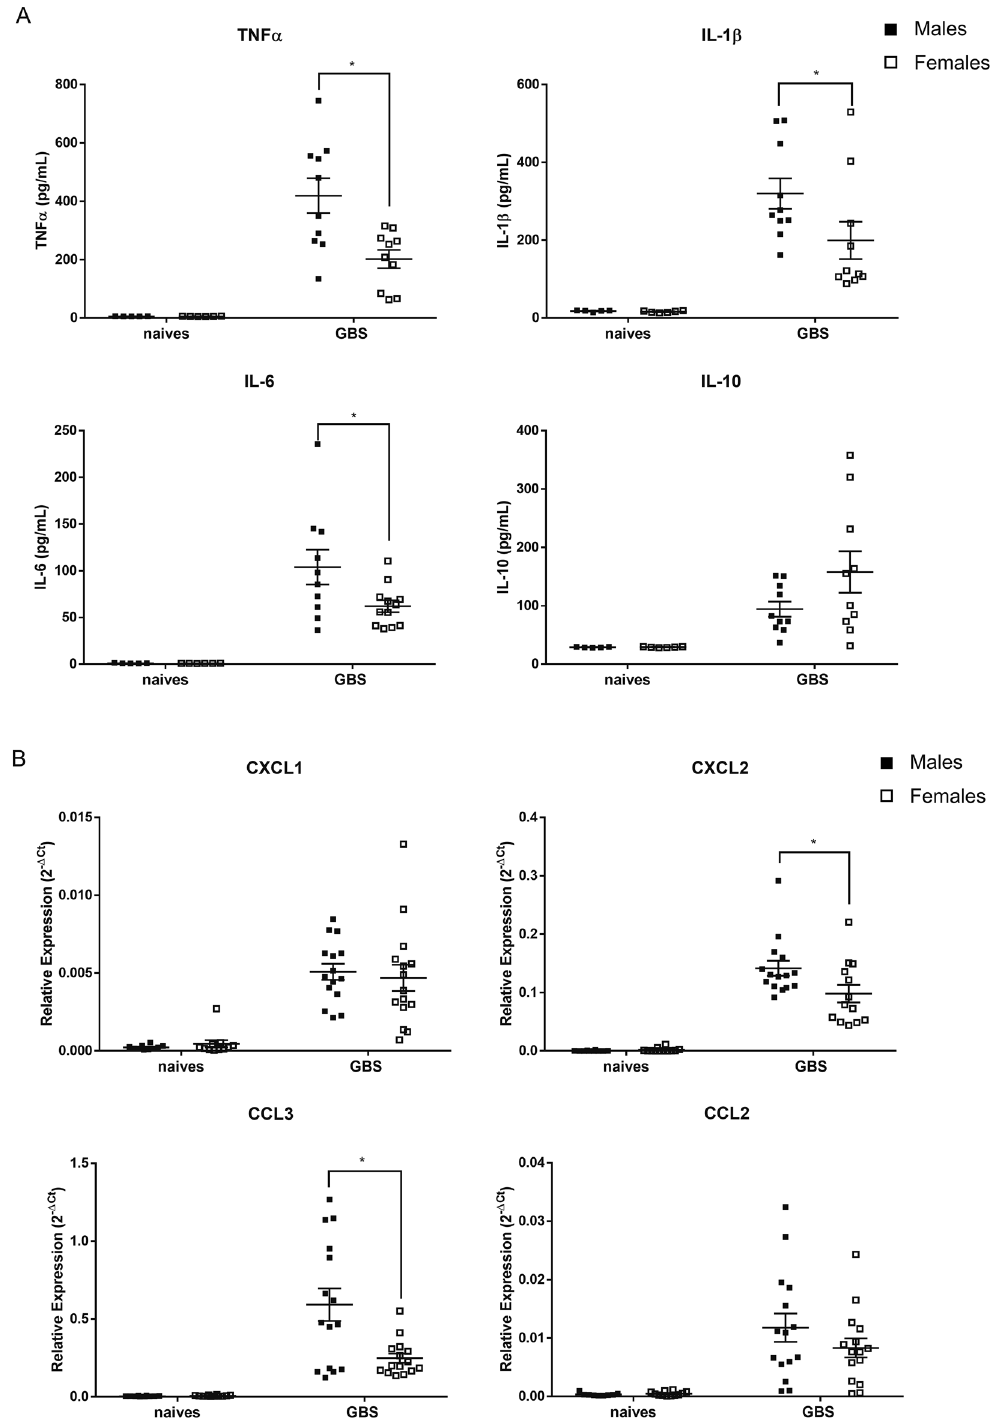
Figure 3. Sex-based assessment of primary cytokine production and chemokines expression in the lungs of GBS-infected mice (24 h pi). ( A ) C57BL/6 male (n = 10) and female (n = 10) mice were infected intranasally with ± 10 8 CFUs of GBS. TNFα, IL-1β, IL-6 and IL-10 were measured 24 h pi, in suspension fluids of pulmonary tissue by ELISA. For naive mice, data were below the limit of detection in all samples. Extrapolated results are shown. *p < 0.05 (Mann–Whitney U test). Data are representative of those from two independent experiments. ( B ) Sex-based assessment of chemokines expression in the lungs of GBS-infected mice. C57BL/6 male (n = 15) and female (n = 15) mice were infected intranasally with ± 10 8 CFUs of GBS. Relative mRNA transcripts of CXCL1, CXCL2, CCL3 and CCL2 were evaluated 24 h pi in the lungs using real-time RT-PCR. The values were normalized with two internal controls, RPL-19 and β-actin. Relative expression results were compared to those obtained for uninfected male (n = 10) and female (n = 10) control mice. *p < 0.05 (Mann–Whitney U test). Data are representative of three independent